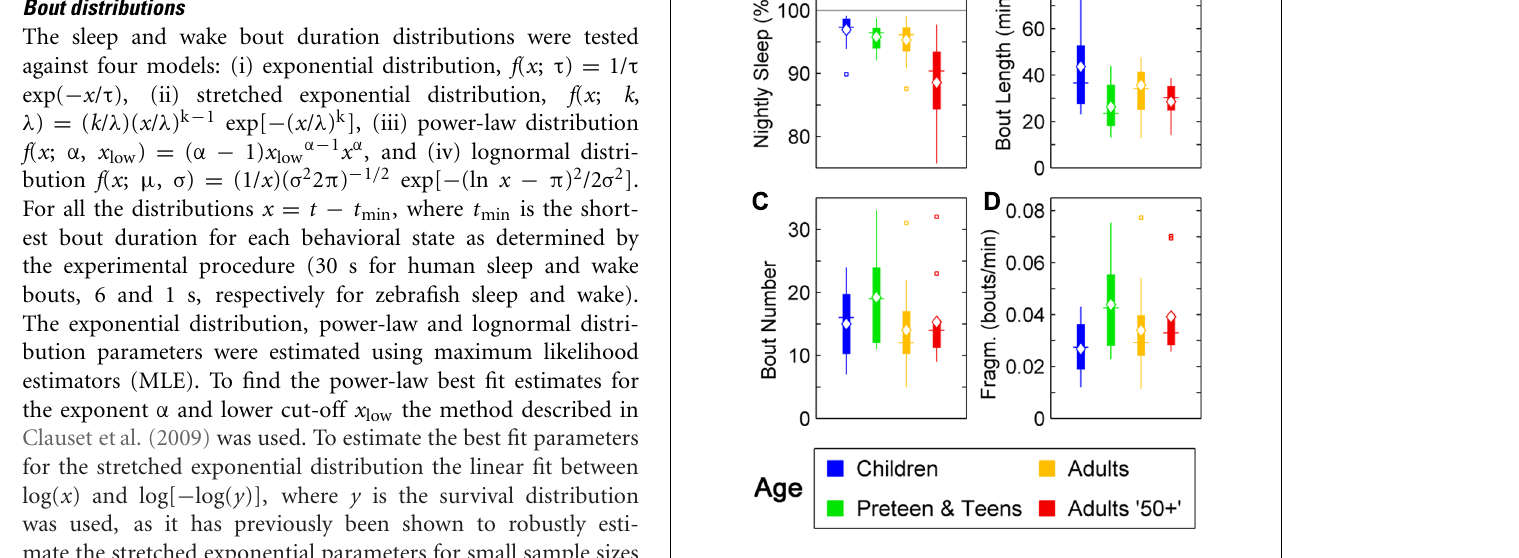
FIGURE 1 | Sleep parameters during the night in humans across age groups: Children (blue), Preteens and teens (green),Adults (orange), andAdults 50 + (red). Colored asterisks above bars indicate a statistically significant difference between the bar group and the group with the corresponding color of the asterisk. (A) Percentage sleep time.The mean percentage of sleep is significantly lower in Adults older than 50 than in all other age groups. (B) Mean sleep bout length.There is no difference between age groups in the mean duration of the sleep bouts. (C) The number of sleep bouts during nightly sleep do not change across the age groups. (D) Sleep bout fragmentation (bouts/min).There are no significant changes of the sleep fragmentation with age. Diamond, white line, and squares indicate mean, median, and outlier values,